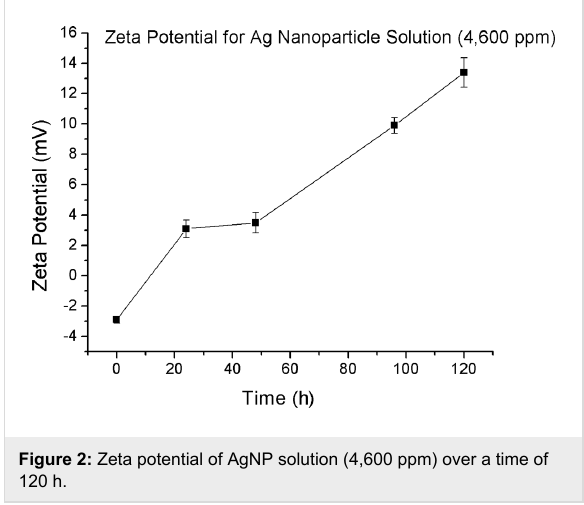
Figure 2: Zeta potential of AgNP solution (4,600 ppm) over a time of 120 h.